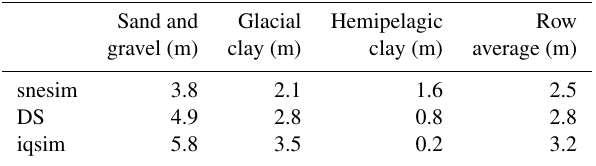
Table 4. The borehole distance results are summarized in this table. The borehole distances are the 3-D Euclidean distances calculated using the concept presented in Sect. 3.6. The presented distance val- ues are the averages of the curves shown in Fig. 10, one average for each of the individual hydrostratigraphic units for each of the pre- sented methods: snesim, DS and iqsim realizations. The last column shows the average distances for each of the three MPS